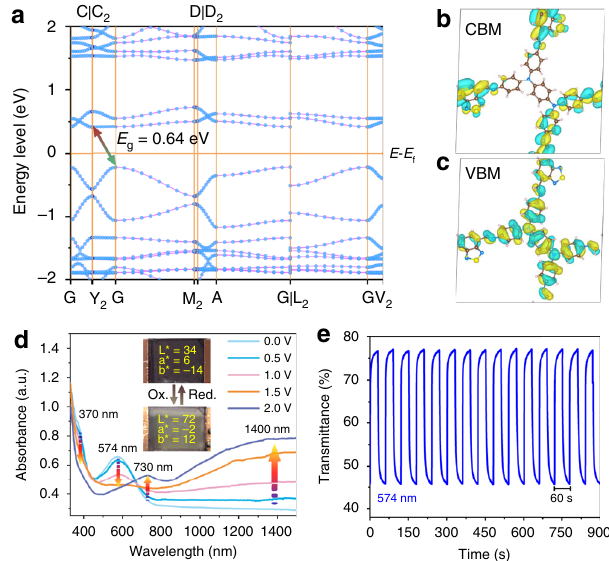
Fig. 3 Electronic structure and characteristics of EC-COF-1. a Band structures. The coordinates of high-symmetry points are Γ — C|C 2 — Y 2 — Γ — M — D|D — A — Γ |L — Γ — V 2 2 2 2 (orange lines). b HOMO at VB. c LUMO at CB. d Changes in the optical spectrum of EC-COF-1 fi lm as a function of applied potential. e Repetitive display of transmittance at 574 nm (blue line) for the voltage between – 1.8 and + 2.0